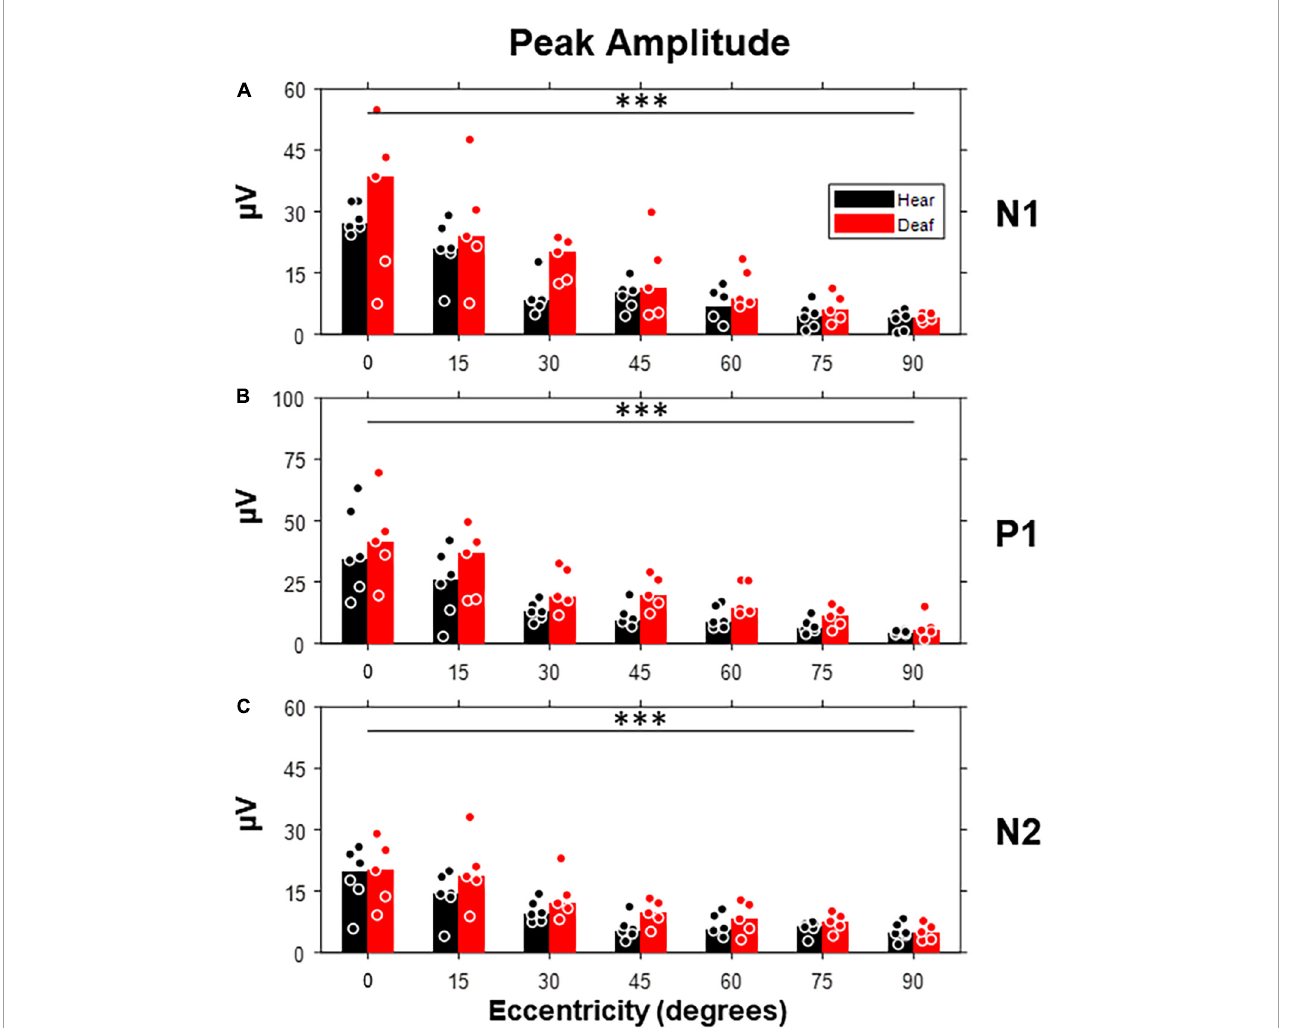
FIGURE5 Peak amplitudes of three VEP components (N1, P1, and N2) as a function of stimulus eccentricity. (A) Peak amplitudes quantified from the N1 component, which is defined as the first negative deflection after stimulus onset. (B) Peak amplitudes quantified from the P1 component, which is defined as the first positive deflection after N1. (C) Peak amplitudes quantified from the N2 component, which is defined as the last negative deflection. Dot, individual subject; bar, median; ∗∗∗ p < 0.001 for the main effect of